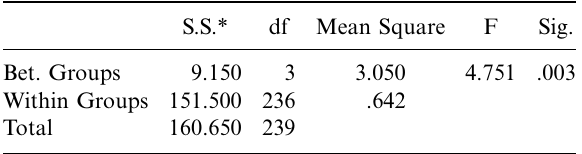
Table 4. Test for homogeneity of sample variability Levene Statistic df1 df2 Sig. 1.971 236 .119